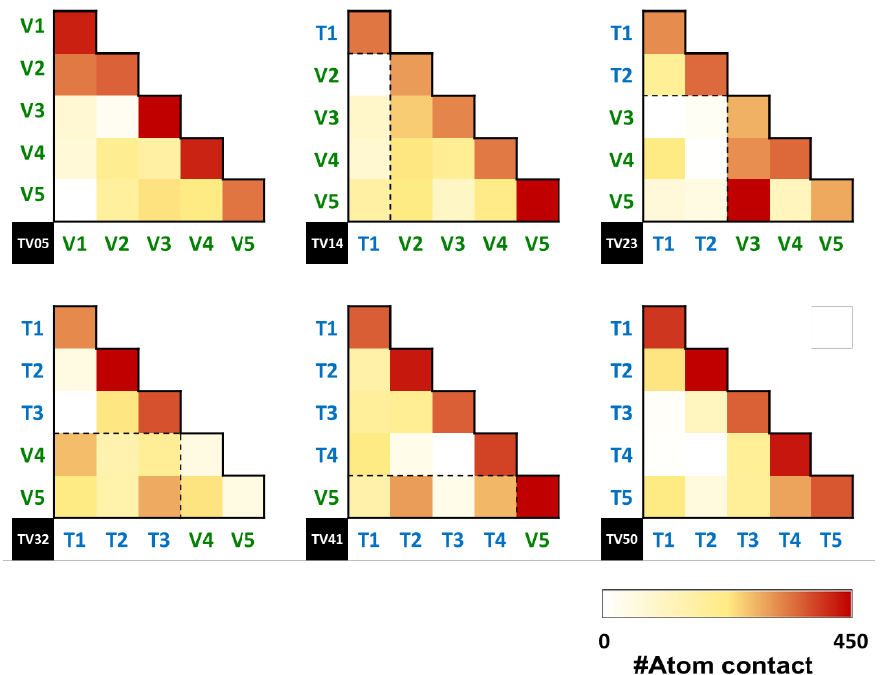
Figure 8. The heatmap of the number of contact atoms between each chain of the PET, PEV, and PET/PEV blends.